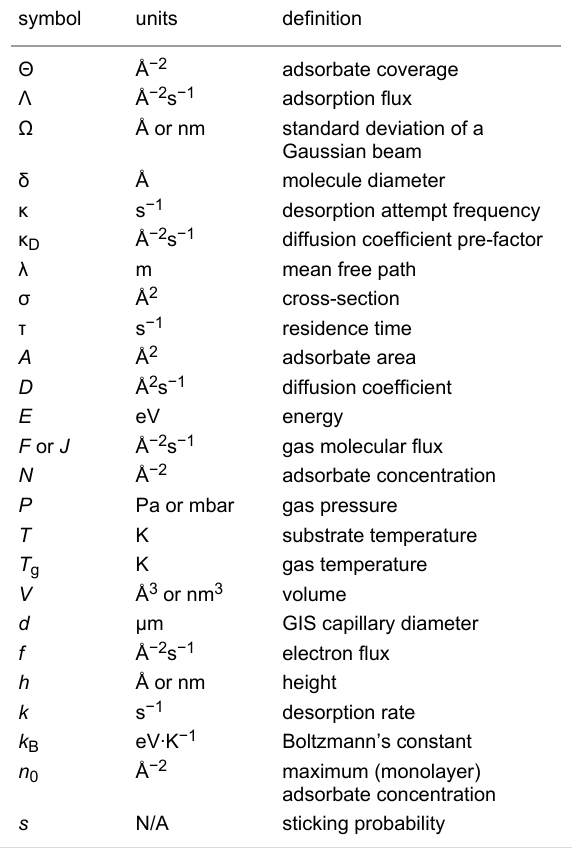
Table 1: Guide to commonly used